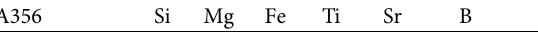
Table 1: Chemical composition of the A356 alloy. A356 Si Mg Fe Ti Sr B